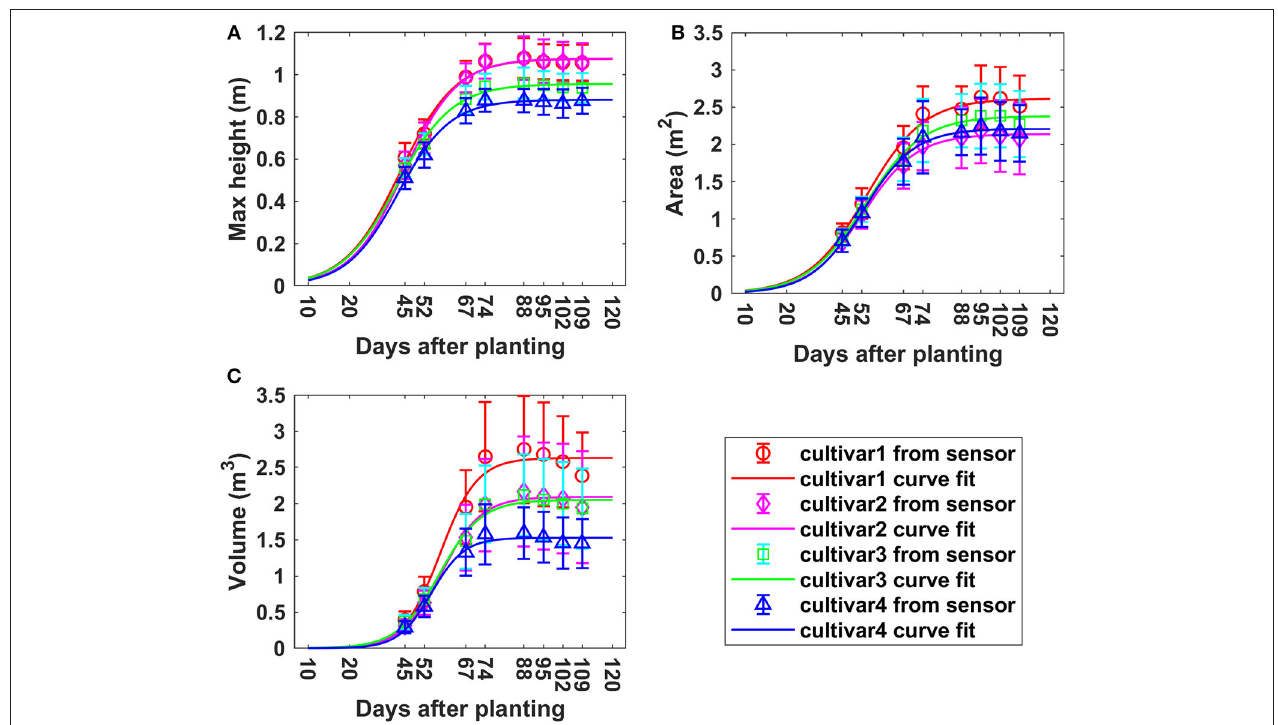
FIGURE 8 | Growth curves for derived morphologic parameters over the monitoring period. (A) Maximum canopy height; (B) projected canopy area; (C) plant volume.